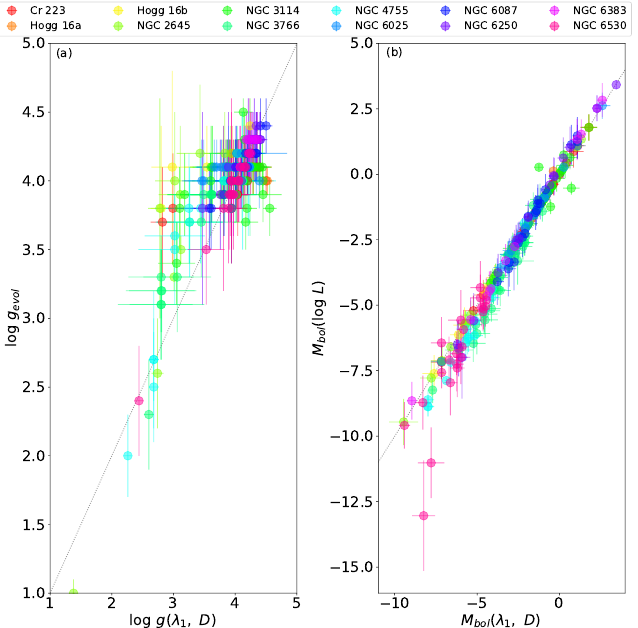
Figure 10. ( a ) Comparison of log g parameters of cluster stars obtained using evolutionary tracks without rotation with those derived from the BCD log g ( λ 1 , D ) calibration. ( b ) Comparison of M bol parameters obtained using the evolutionary tracks of stars without rotation with those derived from the BCD M bol ( λ 1 , D ) calibration. Adapted from Aidelman et al.